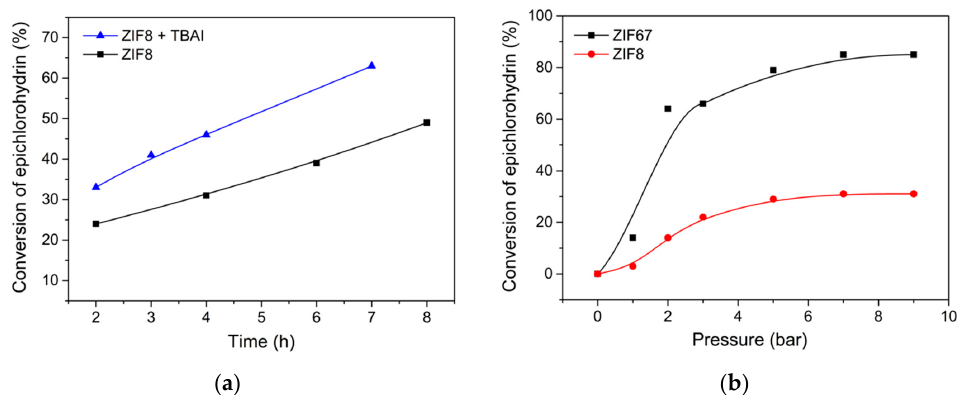
Figure 7. ( a ) Study of the effect of co-catalyst in the reaction of CO 2 with epichlorohydrin using ZIF- 8 as catalyst. Conditions: 97.8 mol.% of epichlorohydrin, 0.6 mol.% of ZIF-8, 1.4 mol.% of TBAI, 60 °C, 7 bar CO 2 . ( b ) Effect of the pressure in the catalytic reaction of cycloaddition of CO 2 with two different catalysts (ZIF-8 and ZIF-67). Conditions: 99.4 mol.% of epichlorohydrin, 0.6 mol.% of ZIF catalysts, 120 °C, 4 h. The conversion of epichlorohydrin was based on 1 H-NMR results (3-chloropropene carbonate was the only